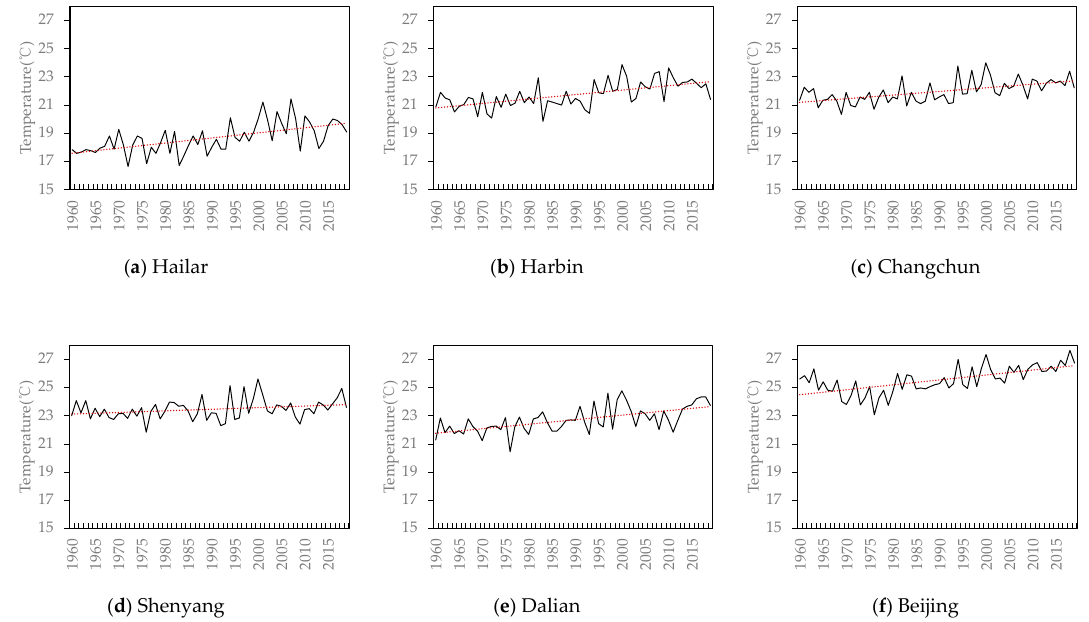
Figure 1. Average summer temperature of major cities in Northeast China (June to August). (Data source: China Meteorological Data Service Center, National Meteorological Information Center, drawn by the authors).